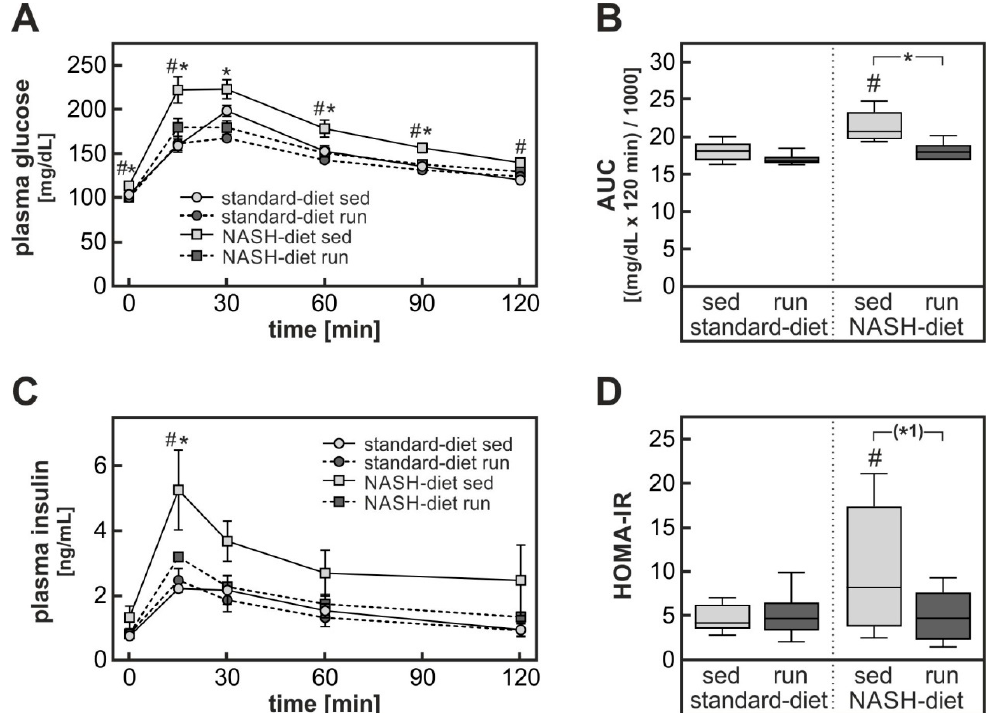
Figure 2. NASH-diet-dependent impairment of glucose tolerance and insulin sensitivity. Rats were subjected to the treatment groups described in the legend to Figure 1. One week before the end of the intervention an i.p. glucose tolerance test was performed (see methods section). ( A ) Blood glucose levels were determined enzymatically. Values are means ± SEM. ( B ) The area under the blood glucose curves (AUC) for every individual animal in ( A ) was determined. Values are median (line), upper and lower quartile (box) and extremes (whiskers). ( C ) Plasma insulin levels during the i.p. glucose tolerance test were determined by ELISA. Values are means ± SEM. ( D ) Homeostatic model assessment of insulin resistance (HOMA-IR) was calculated. Values are median (line), upper and lower quartile (box) and extremes (whiskers). Statistics: ( A , C ) Multiple Student’s t -test for unpaired samples; ( B , D ) Two-way-ANOVA with Tukey’s post hoc test for multiple comparisons; #: significant versus sedentary standard-diet group, *: significant versus exercised NASH-diet group, * p < 0.05, (*1) p < 0.10 between compared groups.